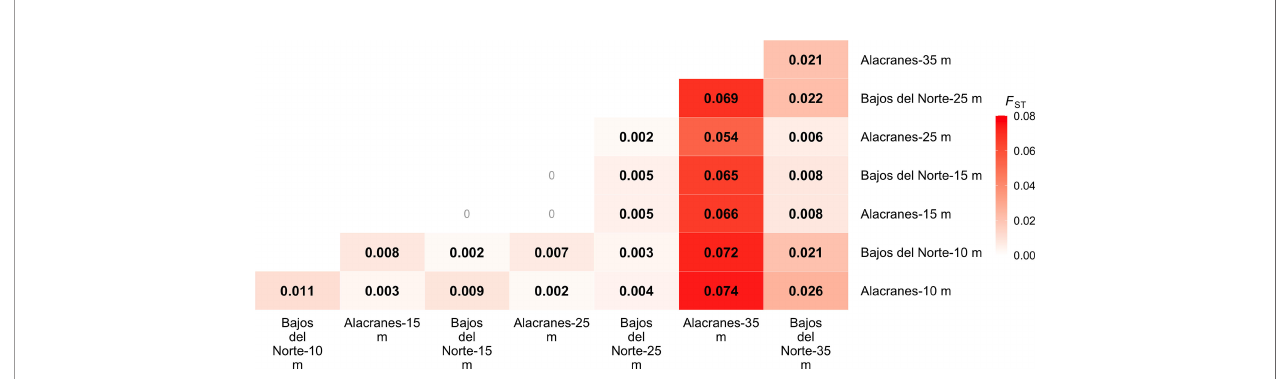
FIGURE 3 | Heat map representations of pairwise population differentiation as estimated by fi xation index ( F ST ). Values within cells are estimated F ST with increasing intensity of the color red corresponding to increasing F ST values. Bolded F ST values denote signi fi cant differentiation between populations (post FDR-correction, p <0.05).